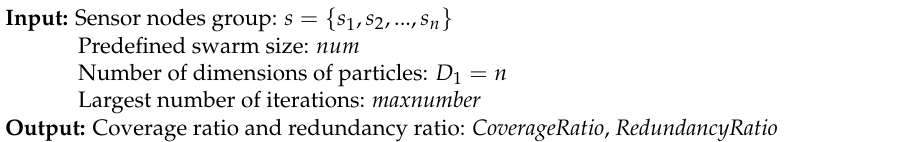
Algorithm 3: Multi-objective area coverage optimization algorithm based on IAPSO